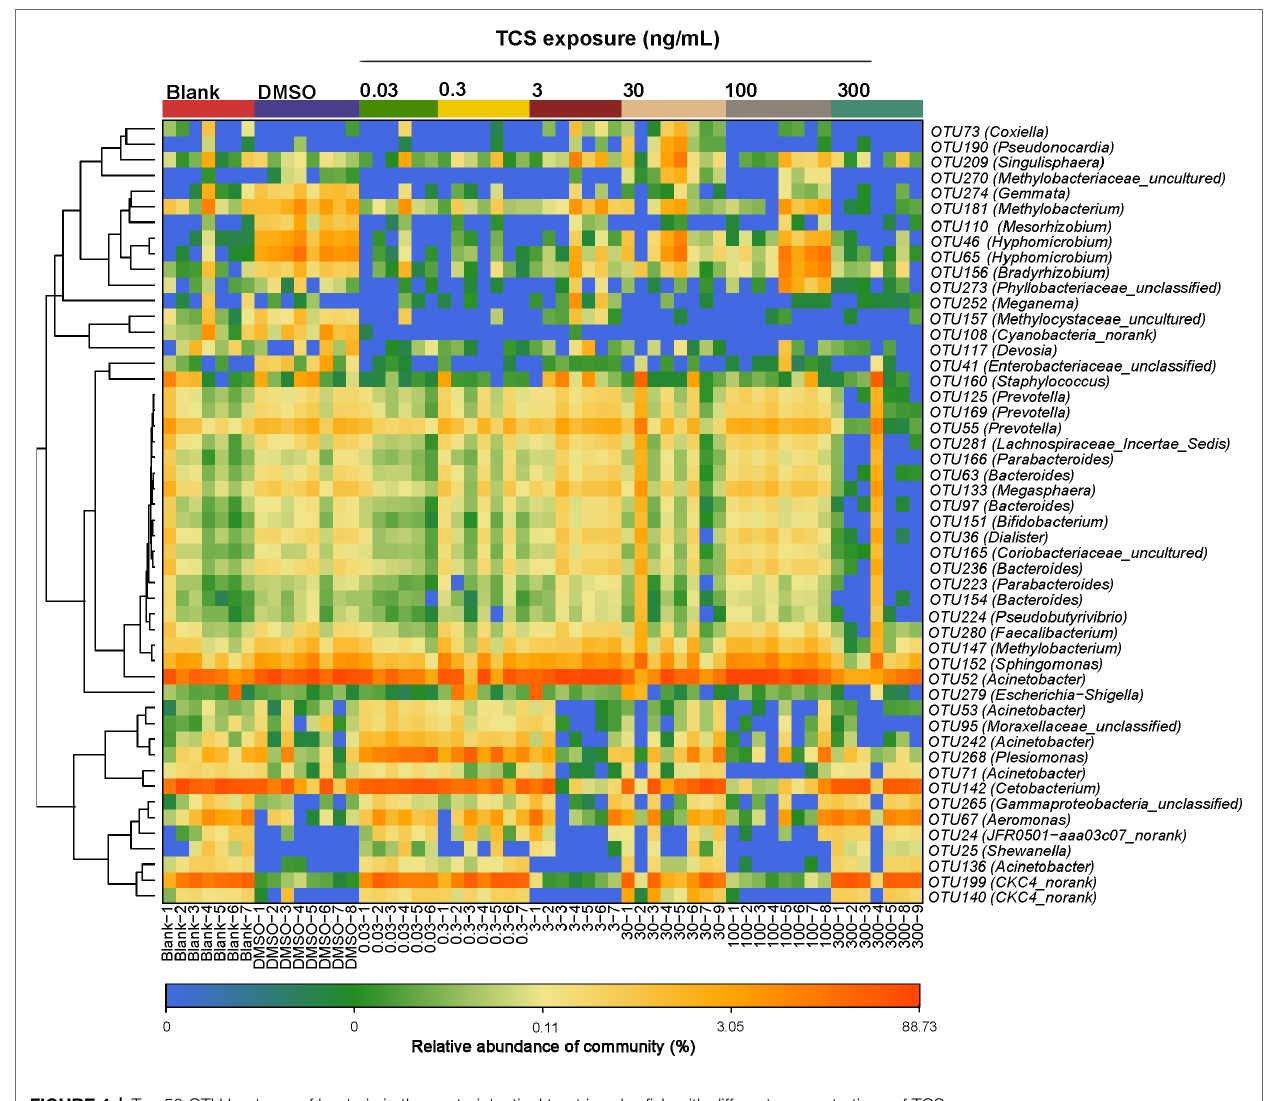
FIGURE 4 | Top 50 OTU heatmap of bacteria in the gastrointestinal tract in zebrafish with different concentrations of TCS